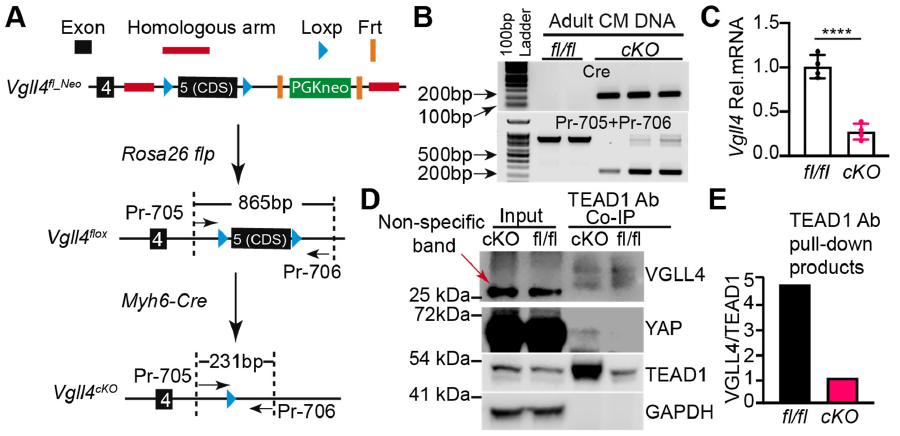
Figure 5. Generation and validation of a Vgll4 flox allele: ( A )cardiac-specific Vgll4 depletion strategy. The coding sequence of exon 5 (exon 5 CDS) was flanked by LoxP sites. A PGKneo selection cassette flanked by Frt sites was used for selection of recombinants. F1 Vgll4 flox_Neo mice were bred to Rosa26 flp mice to remove the PGKneo cassette. Crossing Vgll4 flox allele with Myh6-Cre depleted exon 5 CDS in the CMs; ( B ) PCR validation of Vgll4 exon 5 CDS excision; ( C ) qRT-PCR measurement of Vgll4 mRNA. Student’s t -test, **** p < 0.0001, N = 4; ( B , C ) adult hearts were dissociated to yield purified CMs for DNA ( B ) and RNA ( C ) isolation; ( D ) co-immunoprecipitation (Co-IP) assay. Mouse origin TEAD1 antibody (BD, 610923) was used to pull down VGLL4 from heart lysate, and Rabbit origin TEAD1 antibody (CST, 12292S) was used in immunoblot to detect TEAD1. Red arrow indicates a non-specific band. GAPDH was used as loading control; ( E ) VGLL4 and TEAD1 protein ratio, determined by quantification of ( D ). Precipitated VGLL4 proteins were normalized to TEAD1.